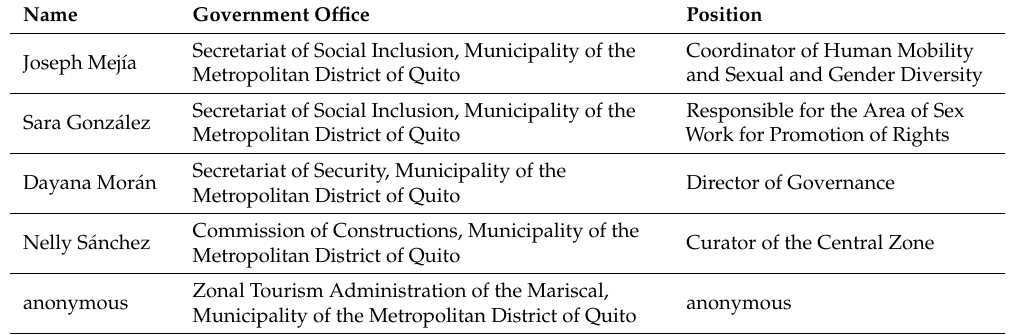
Table A7. Interviews with government officials in Ecuador.